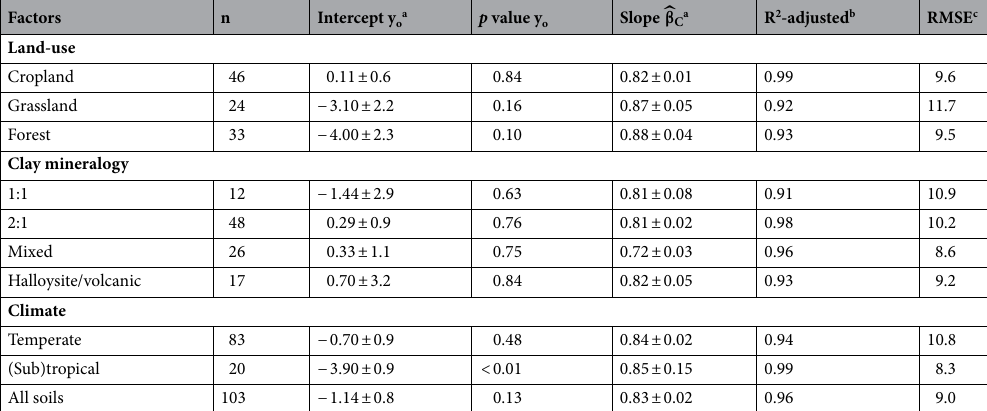
Table 3. Ordinary least squares linear regression between carbon in particles < 63 µm and organic carbon in the bulk soil of published results (± standard error). See the references in Table 1. a y = y o + (cid:31) β C the slope and and ω is SOC content of bulk soil . p values of SOC in the size fraction < 63 µm, significant p < 0.0001. b Coefficient of determination between models with different numbers of parameters. c Root mean square error of predicted proportion of SOC in the silt + clay fraction.